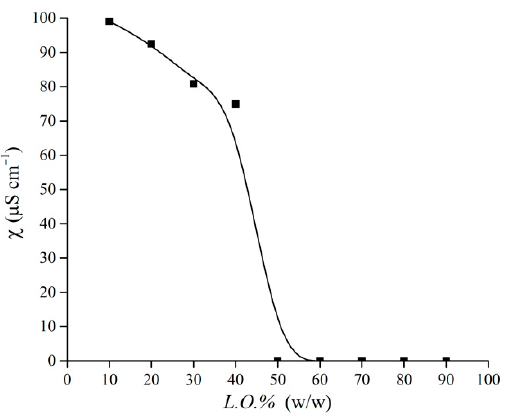
Figure 3. Specific conductivity of water/L.O./(Tween80 + Span80) emulsions as a function of the oil content L.O.% at 25 ◦ C. The total surfactant amount was fixed to 4% in weight with respect to the content L.O.% at 25 °C. The total surfactant amount was fixed to 4% in weight with respect to the total sample amount, and surfactant composition was α Span80 = 0.4 in all total sample amount, and surfactant composition was α Span80 = 0.4 in all samples.